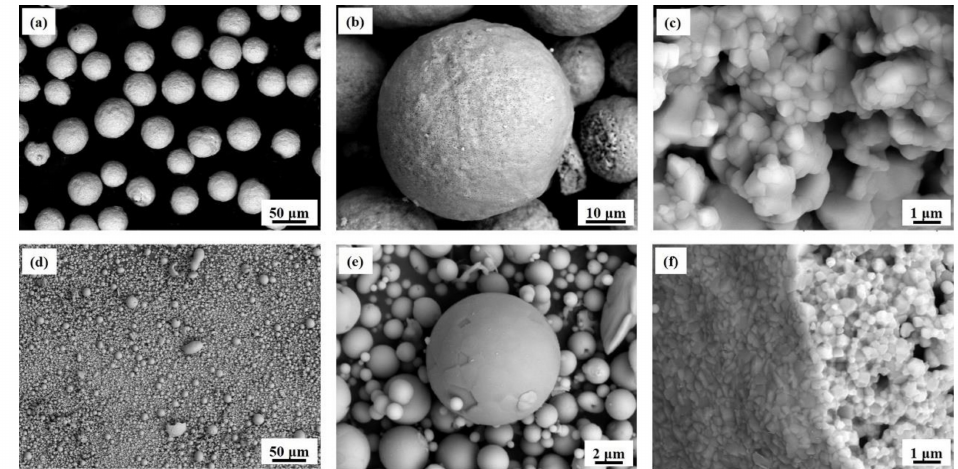
Figure 2. SEM images of powder used for plasma spray: ( a ) feedstock powder after sieving; ( b ) high-magnification image of single feedstock powder; ( c ) grain morphology in the inside of feedstock powder; ( d ) refinement powder morphology after water collection; ( e ) high-magnification morphology of single refinement powder; ( f ) grain morphology in the inside of refinement